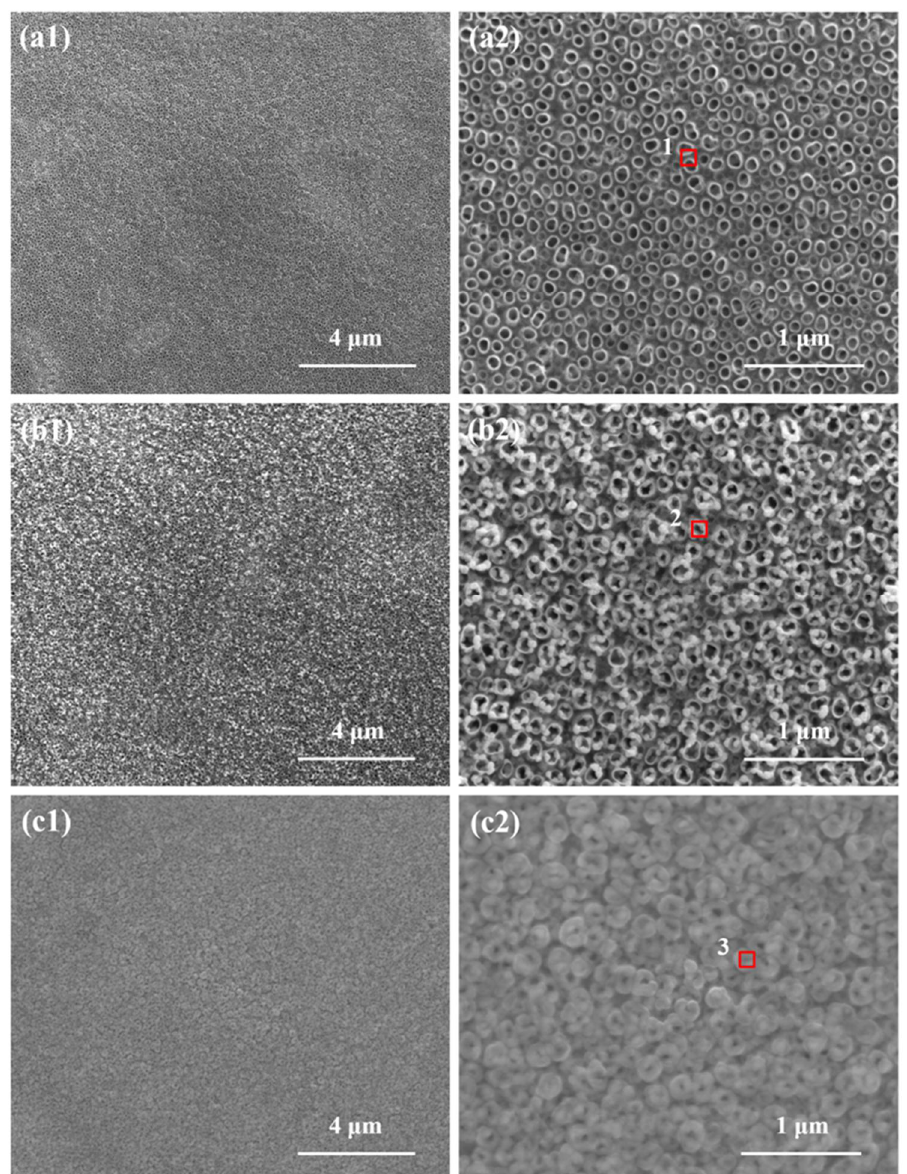
Figure 1. SEM morphology of different electrode surfaces: ( a 1, a 2) TNT; ( b 1, b 2) Ni/TNT; and ( c 1, c 2) Ni − DLC/TNT membrane layers. The elemental analysis in Figure 2 demonstrates the successful deposition of Ni with an atomic ratio of 4.1% for Ni/TNTs and 6.13% for Ni − DLC/TNTs, respectively, after magnetron sputtering. The three red small box identifier showed that after the deposition of Ni nanoparticles, the Ni NPs were dispersed and uniformly distributed on the surface of the TiO 2 nanotubes. As can be seen in Figure 1c, after the sputtering deposition of Ni − doped DLC film on the surface of the nanotubes, the opening end of the nanotubes decreased and the sur-face retained the morphology and roughness of the